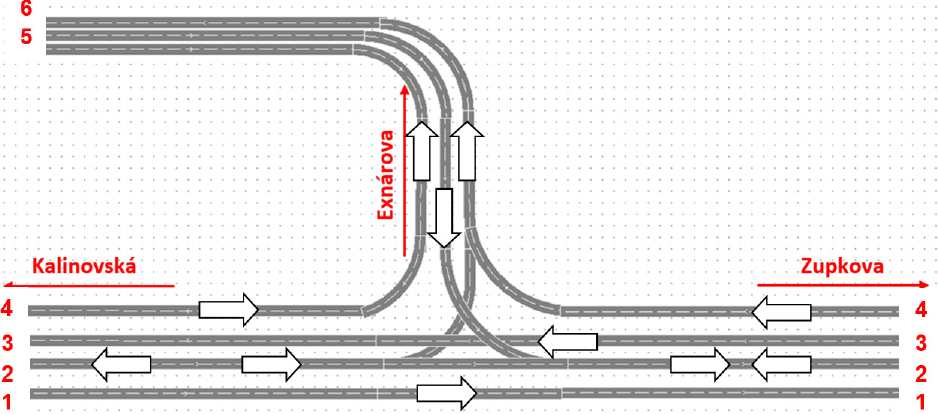
Figure 4. Creation of lanes in a simulated